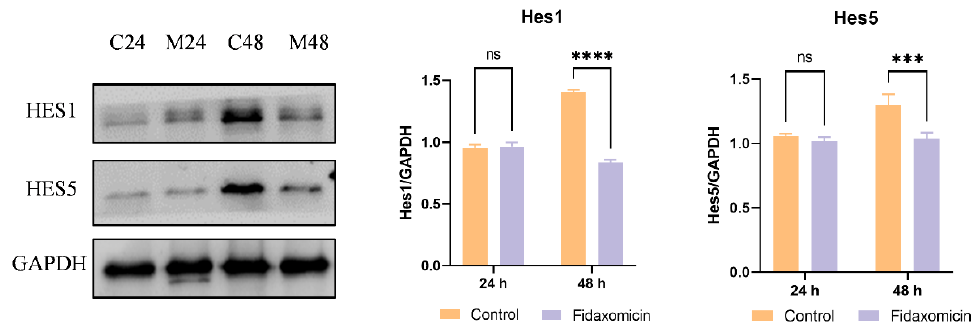
Figure 8. Western blot analysis of protein levels of Notch target molecules in 4T1 cells. C24 and C48 denote the protein levels in untreated 4T1 cells after culture for 24 h and 48 h, respectively. M24 and M48 indicate the protein levels in cells after fidaxomicin treatment for 24 h and 48 h, respectively. After incubation, whole-cell extracts were subjected to immunoblot analysis and incubated with antibodies to Hes1, Hes5, and GAPDH as a control. Data shown represent the mean ± SD of triplicate experiments (*** p < 0.001, and **** p < 0.0001 vs. control group, ns: no significance).